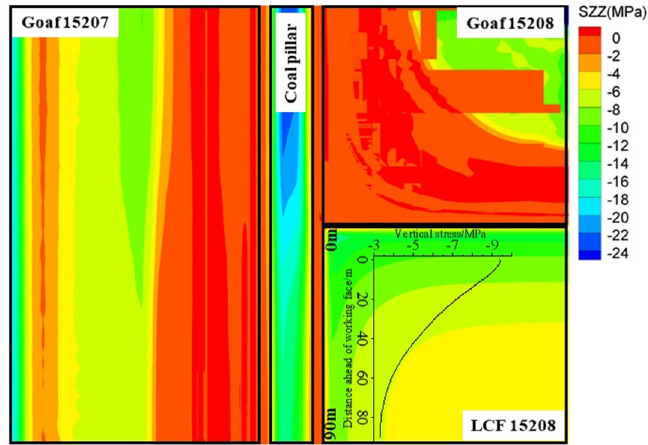
Figure 3. Vertical stress distribution.